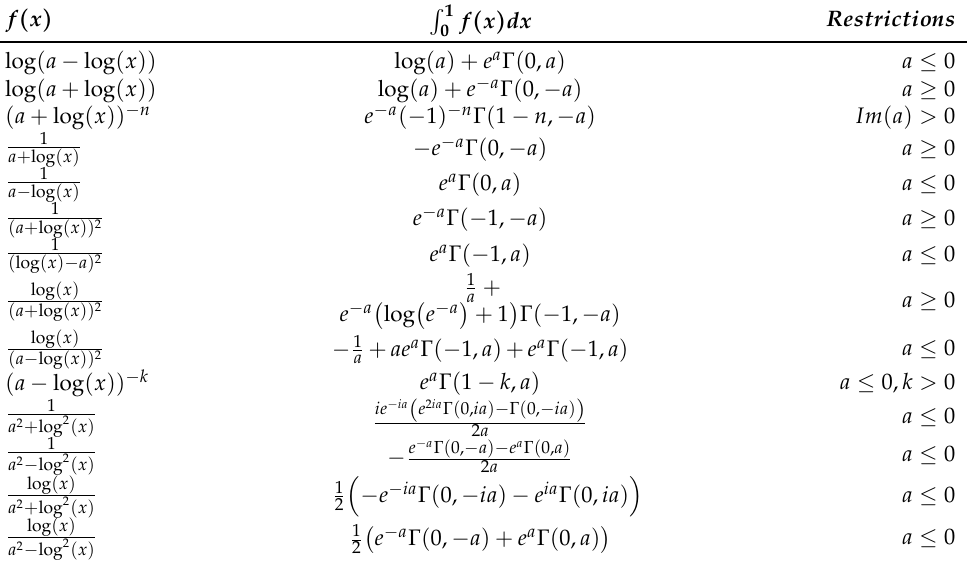
Table 1. Table of definite integrals in work of Gradshteyn and Ryzhik.